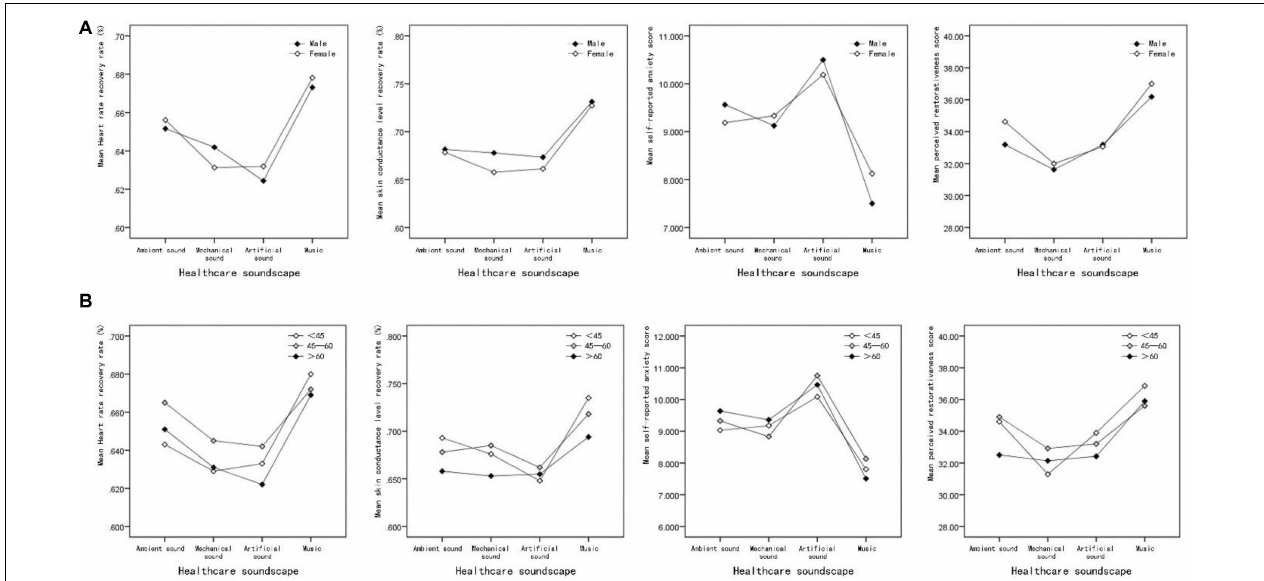
FIGURE 6 | (A) The interaction effects of gender and acoustic environment on patients’ stress recovery. (B) The interaction effects of age and acoustic environment on patients’ stress